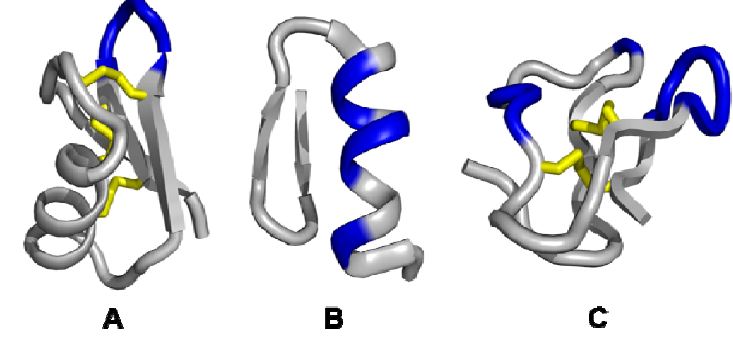
Figure 2. Schematic representations of different scaffold categories. The first type